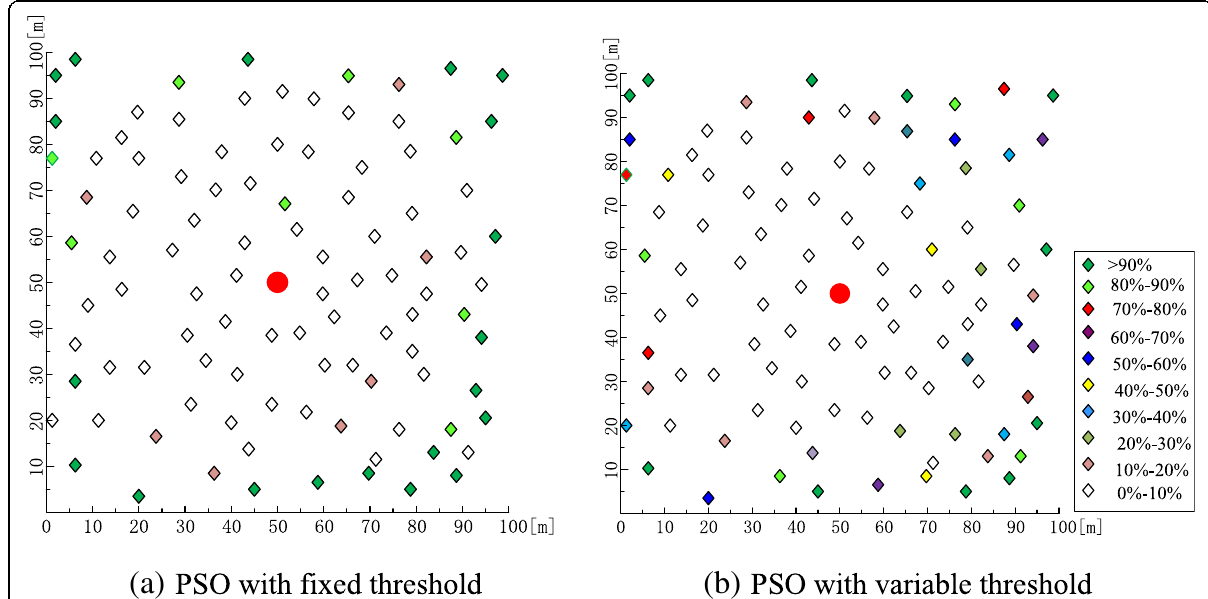
Fig. 17 Comparison of remaining energy distribution map. This figure shows the distribution map of the energy consumption of the network constructed by the proposed reconstruction method, where a corresponds to the topology construction method using PSO algorithm and reconstruction method with fixed threshold; b corresponds to the topology construction method using PSO algorithm and reconstruction